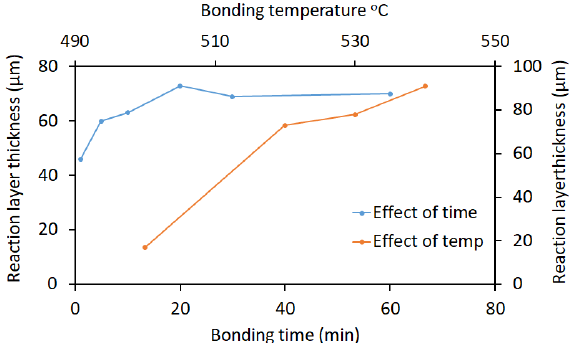
Figure 3. Relationship between the width of the reaction layer bonding time for Ti-6Al-4V and 316 stainless steel [59].